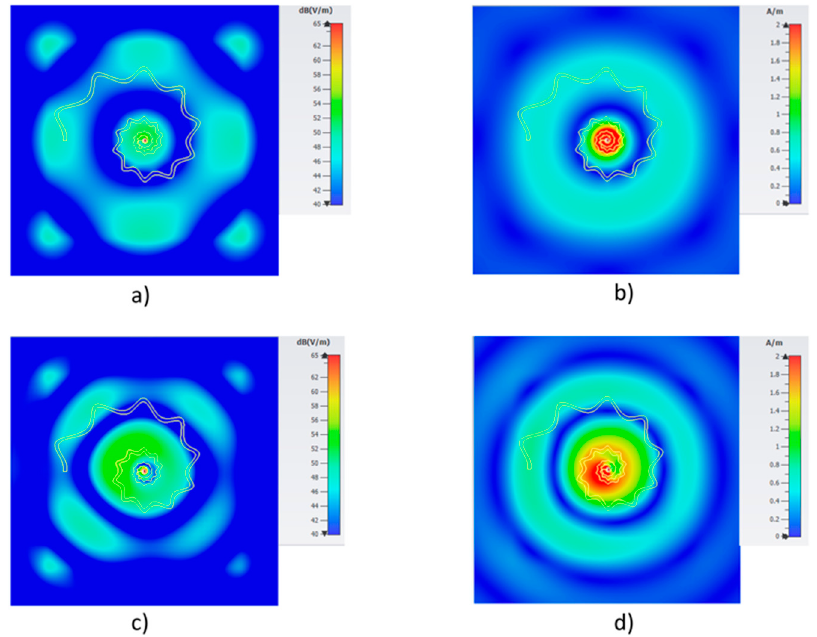
Figure 8. ( a ) Electric field and ( b ) magnetic field intensities at 3.5 GHz; ( c ) electric field and ( d ) magnetic field intensities at 5.5 GHz for the optimized SsDRA. The yellow lines define the SsDRA contour.